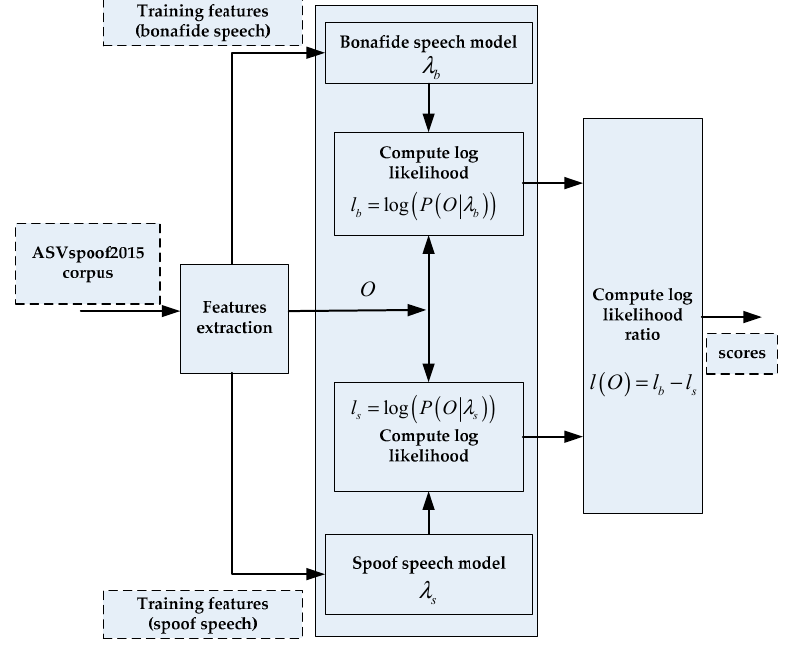
Figure 3. A block diagram showing various steps of the Gaussian mixture model (GMM)-based stand- alone spoofing detection